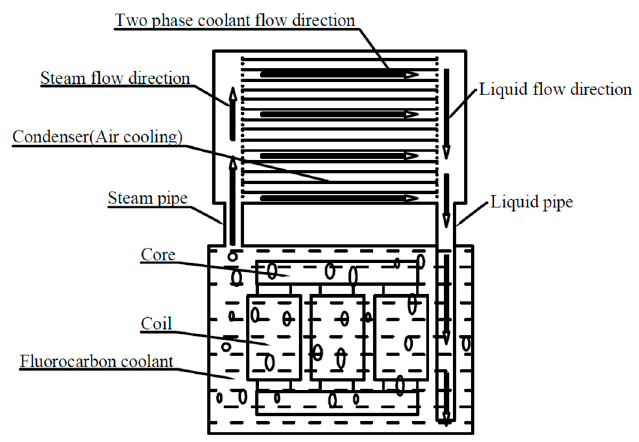
Figure 2. Schematic diagram of transformer evaporative cooling technology.